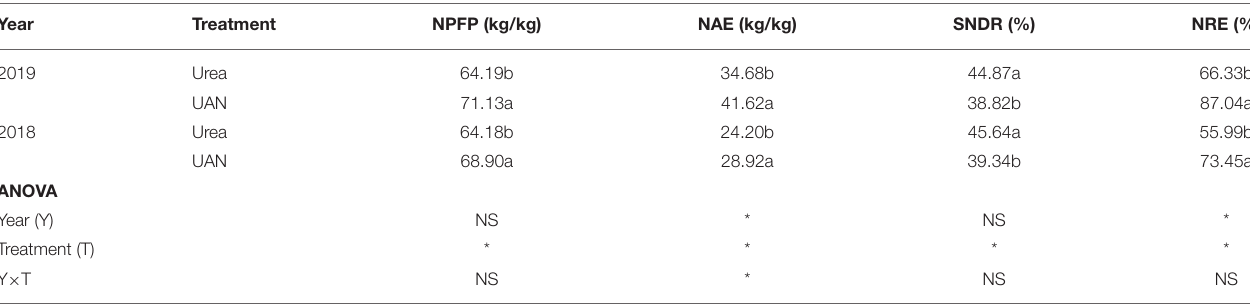
TABLE 4 | Effects of nitrogen fertilizer types on nitrogen efficiency of summer maize.